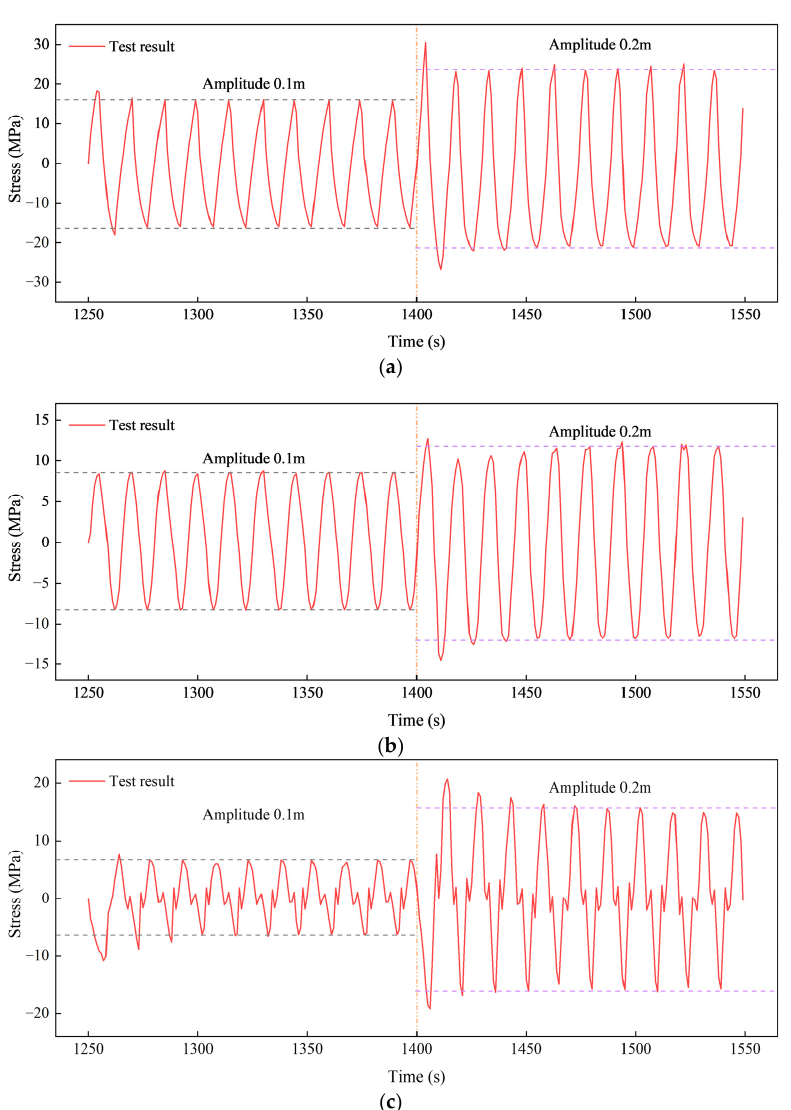
Figure 32. Time history of stress when the horizontal displacements were applied: ( a ) S2; ( b ) S5 and ( c ) S8.